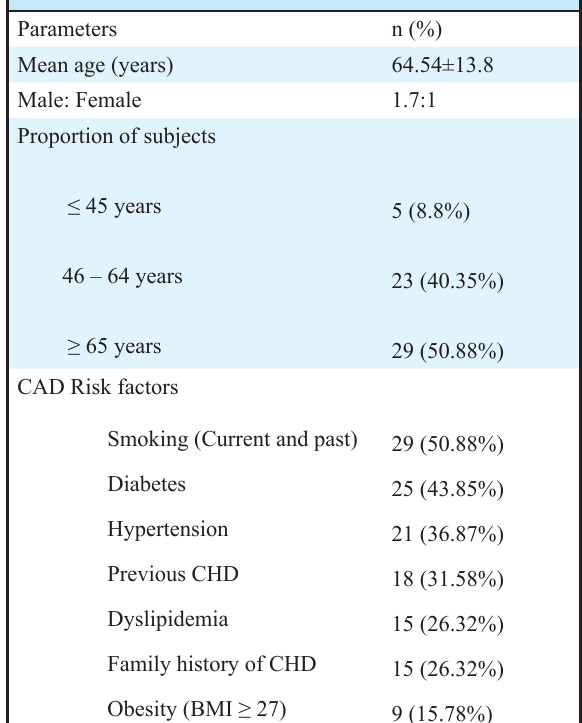
Table 1. Patient baseline characteristics